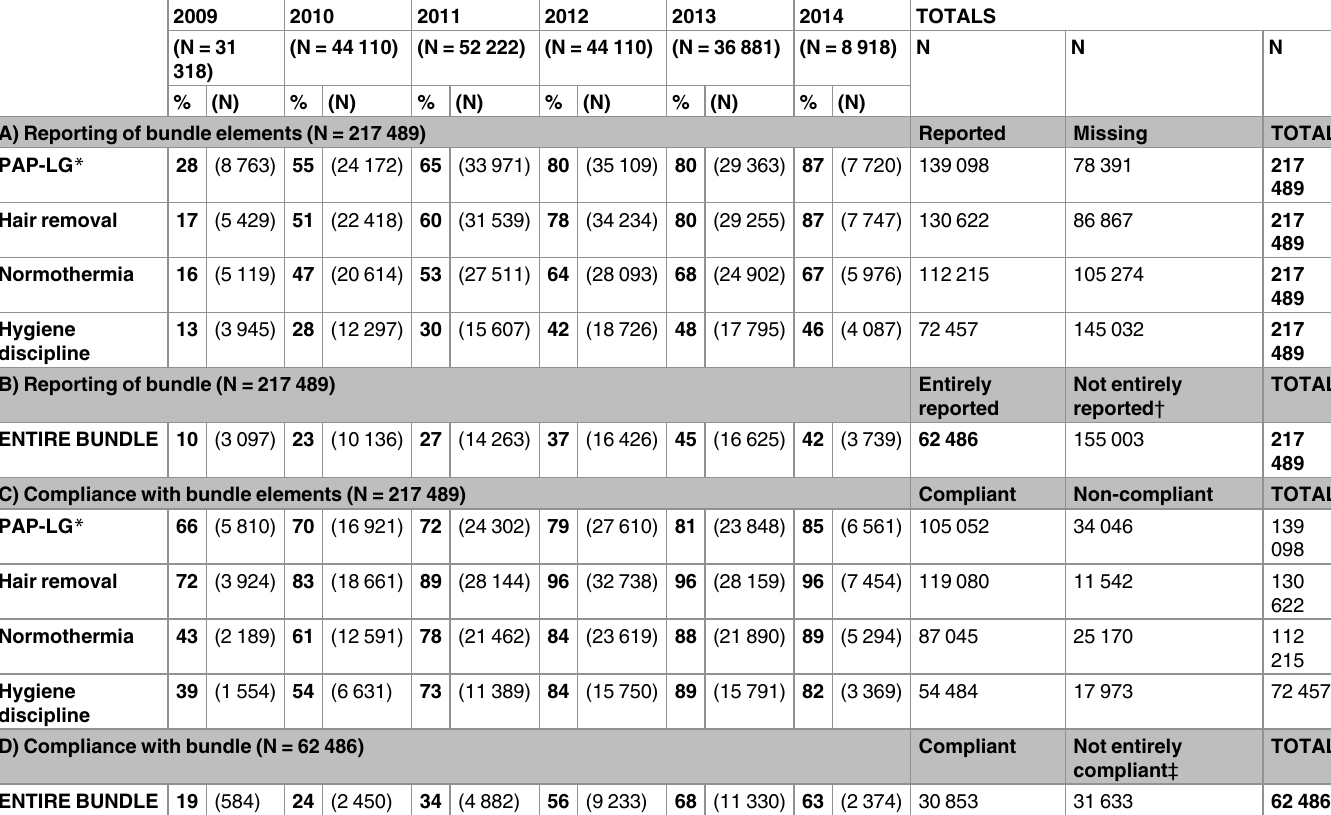
Table 4. Reporting of and compliance with the bundle and its